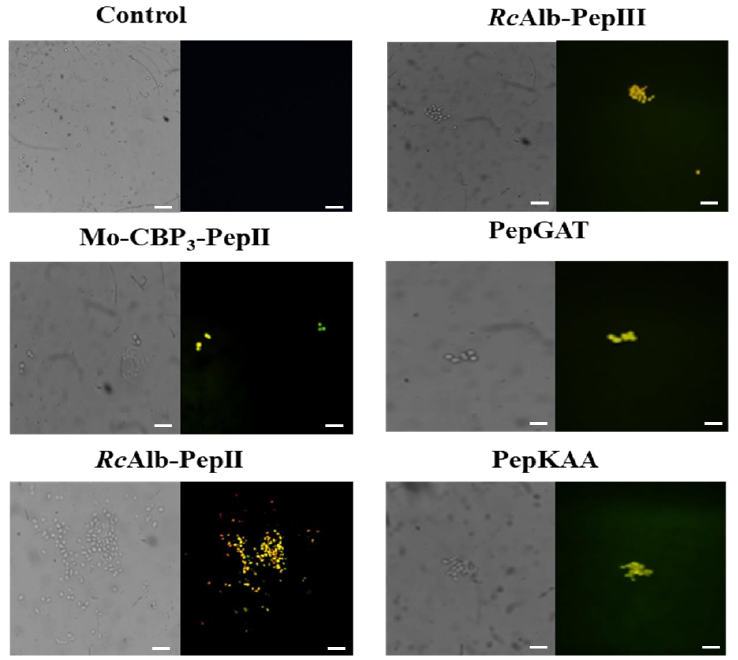
Figure 4. DNA fragmentation in C. neoformans cells induced by Mo -CBP 3 -PepII, Rc AlbPepII, Rc Alb- PepIII, PepGAT, and PepKAA, respectively, at 25, 0.04, 0.04, 0.04, and 0.04 µg mL − 1 . The cells were treated with peptides, and the control negative was DMSONaCl. Bars: 100 µm. As peptides induced DNA degradation in C. neoformans , we reasoned that the peptides could also induce apoptosis in C. neoformans cells. A Caspase-3/7 Green Detection kit evaluated the activity of caspases. The activity of caspase-3/7, which suggests that the cell is in apoptosis, was observed in all the cells treated with synthetics peptides (MIC 50 ) (Figure 5). The control, as expected, was not observed in fluorescence.